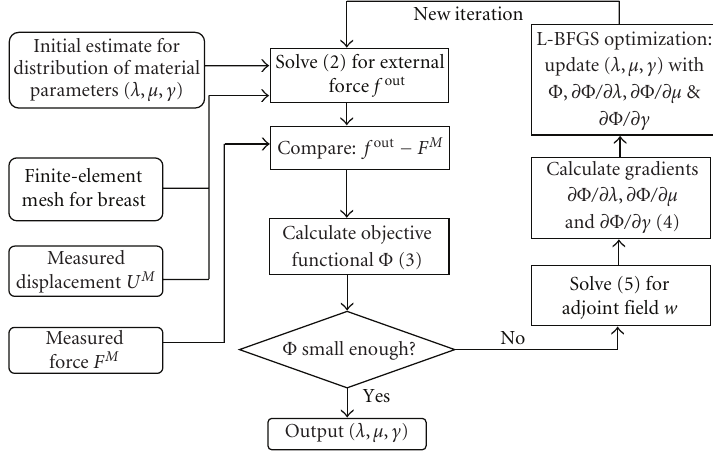
Figure 1: Overall flowchart for nonlinear reconstruction of material parameters λ , μ , and γ of breast tissues.